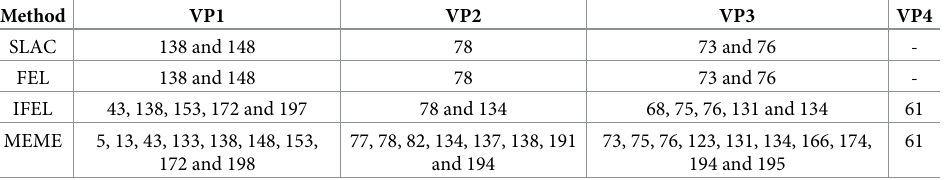
Table 4. Amino acid sites identified to be under positive selection in different viral proteins (VP1-VP4) by differ- ent site specific models (p <